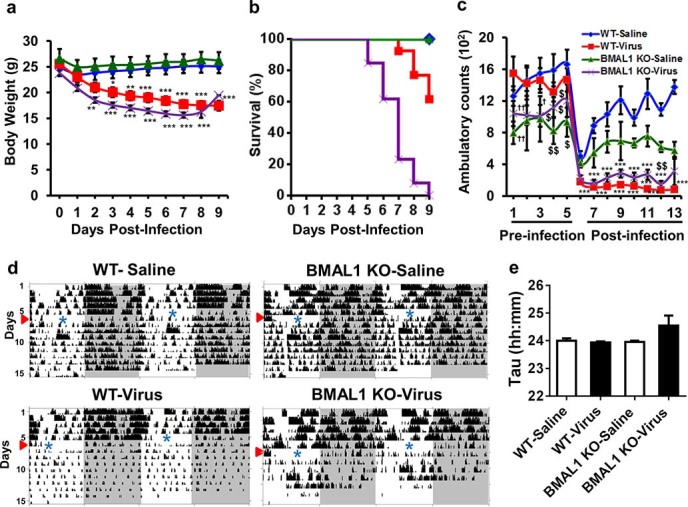
Influenza A virus infection differentially affects body weight, mortality and
behavior in wild-type (WT) and BMAL1 KO mice.(a) IAV infection significantly reduced body weight of both WT and
BMAL1 KO mice on day 2–9 post-infection compared to uninfected
controls. * P < 0.05; ** P < 0.01; ***
P < 0.001 significant compared to WT-Saline or BMAL1
KO-Saline; (b) Mortality was increased following IAV infection in
both WT and BMAL1 KO mice, reaching 100% in BMAL1 KO mice within 9 days
post-infection. Data are representative of mean ± SEM (n = 10
WT-Saline; n = 4 BMAL1 KO-Saline; n = 13 WT-Virus; n = 13 BMAL1 KO-Virus).
Survival over time was analyzed with a Mantel-Cox test (P
< 0.001). (c) Nocturnal activity of IAV infected mice
(both WT and BMAL1 KO) was reduced on days 1–8 post-infection
when compared to uninfected controls. ***P < 0.001
significant compared to uninfected controls; $ P
< 0.05; $$ P < 0.01 significant
compared to WT-Saline treated mice; ††
P < 0.01 significant compared to WT-Virus infected mice.
(d) Representative double plotted actograms showing considerable
reduction in total cage activity of IAV infected WT and BMAL1 KO mice
relative to uninfected controls. In panel d, gray shading indicates
the dark phase (ZT12-24) and activity was not recorded during body weight
measurements (ZT5-6). Red arrow head indicates day 0 IAV infection and
asterisks denotes the time during which the mice were infected with IAV
(ZT4-6). (e) Periodogram analysis of activity in L:D was calculated
during days 1–8 post-infection. Though there was no overall
effect of IAV infection on period in either group an increase in variation
was detected following infection in BMAL1 KO mice. Data are mean
± SEM (n = 10 WT-Saline; n = 13WT-Virus; n = 4 BMAL1 KO-Saline; n
= 13 BMAL1 KO-Virus).